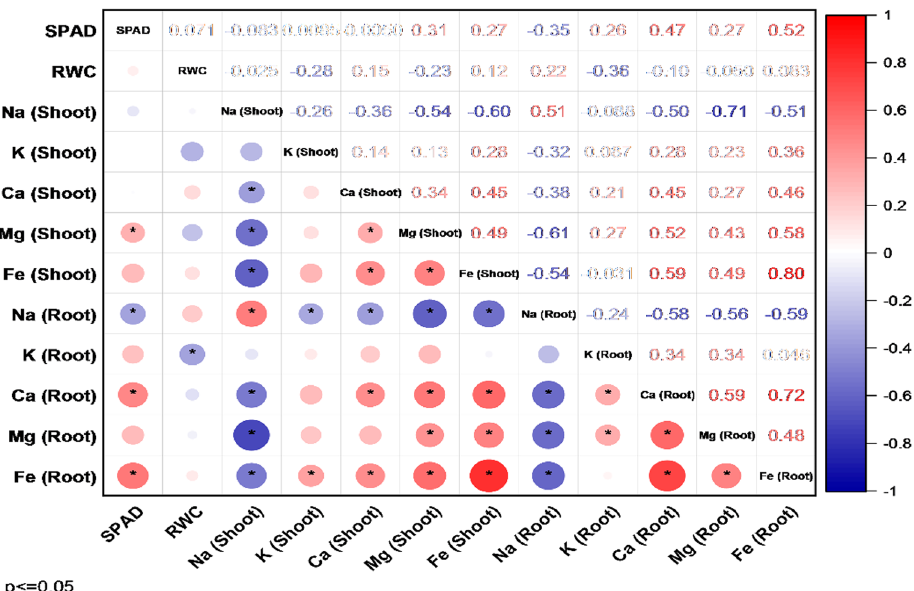
Figure 4. Correlation plot between SPAD, RWC, and shoot and root elements. The size and color intensity of circles are proportional to Pearson’s correlation coefficient at P < 0.01. Red circles indicate positive correlations, while blue are negative correlations. In the correlogram scale from − 1 to + 1, Pearson’s correlation coefficient for variables is on the vertical and horizontal axis. *Indicates values that are statistically different at P < 0.05. A correlation plot was drawn with Origin Pro software version 2021.